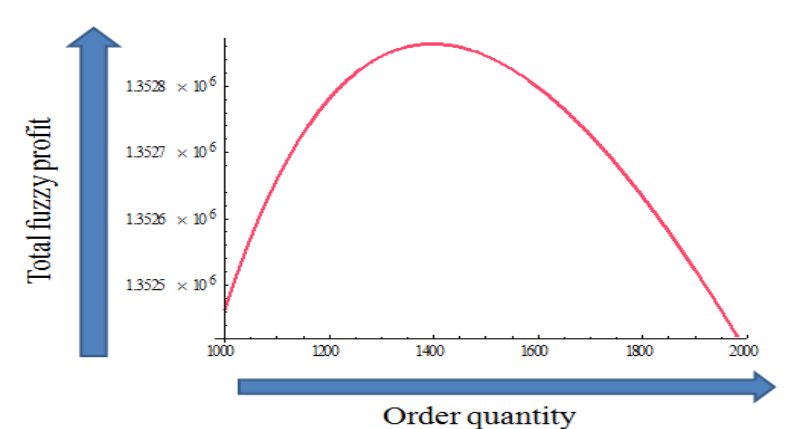
Figure 9. Concavity of total fuzzy profit for Scenario-3. 6.2. Algorithm To compute the problem stated here, the algorithm method of Shinn and Hwang [17] needs to be implemented. Step